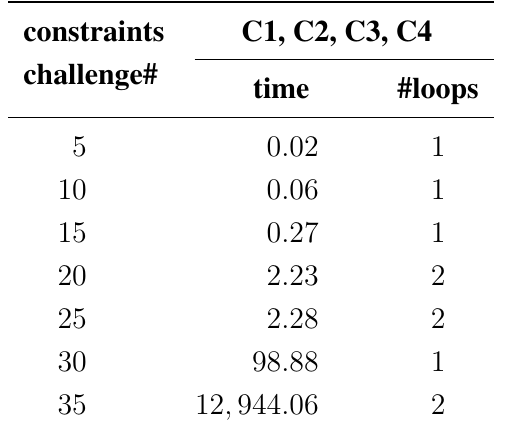
Table 1. Computational time (s) of solving IP formulations using constraints C1, C2, C3 and C4, and the number of loops in each solution.